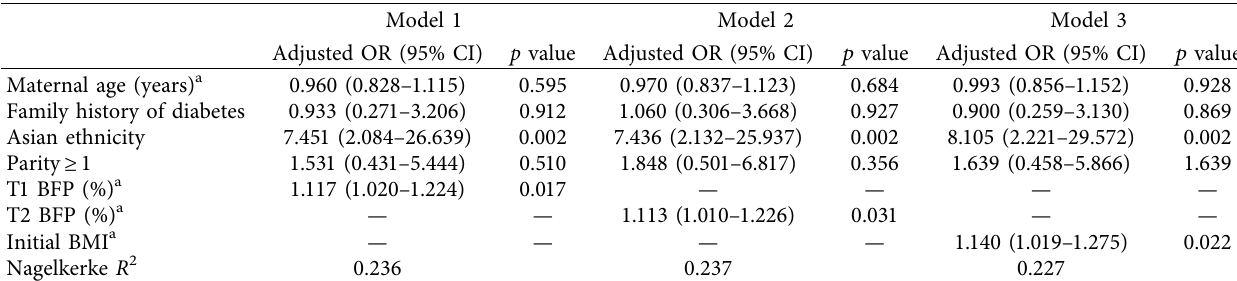
Table 7: Logistic regression models of predictors of GDM.